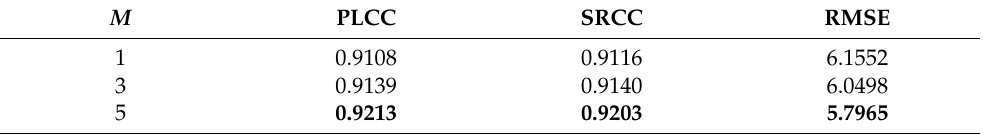
Table 7. Performance results of the proposed method with different scales on the SIQAD